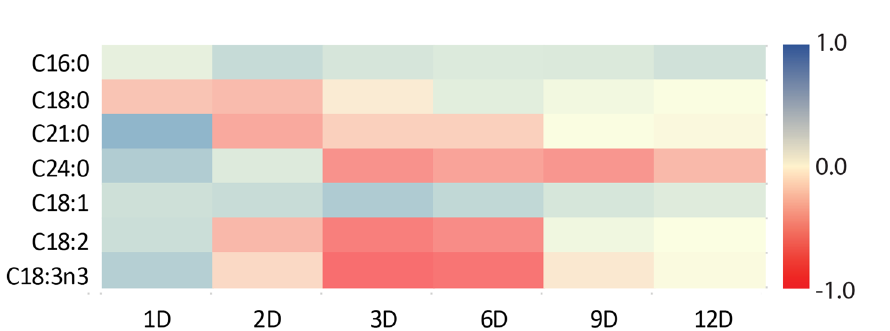
Figure 6. Heat-map plotting of differential fatty acid compositions (fold change ratio) of M. gracile SE-MC4 during early (day 1, 2 and 3), mid (day 6 and 9) and late treatment (day 12) of nitrate starve (NS) and nitrate replete (NR) conditions. Positive differential fold changed were in blue color, while negative differential fold changed were in red color